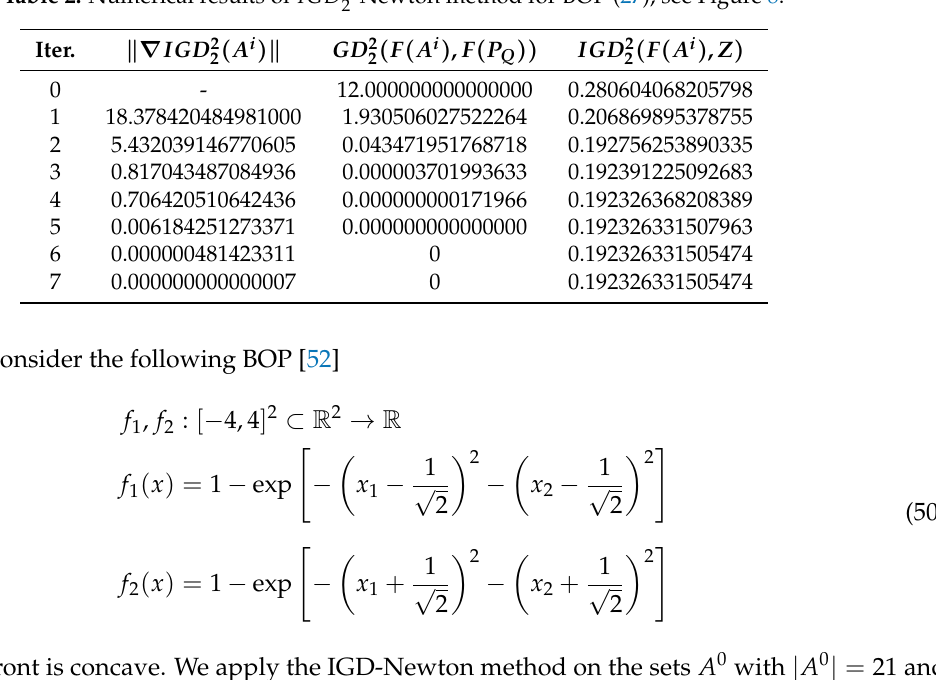
Figure 8. ( Left ) application of the IGD 2 archive (green) together with the images for those m l = 0 (red). Table 2. Numerical results of IGD 2